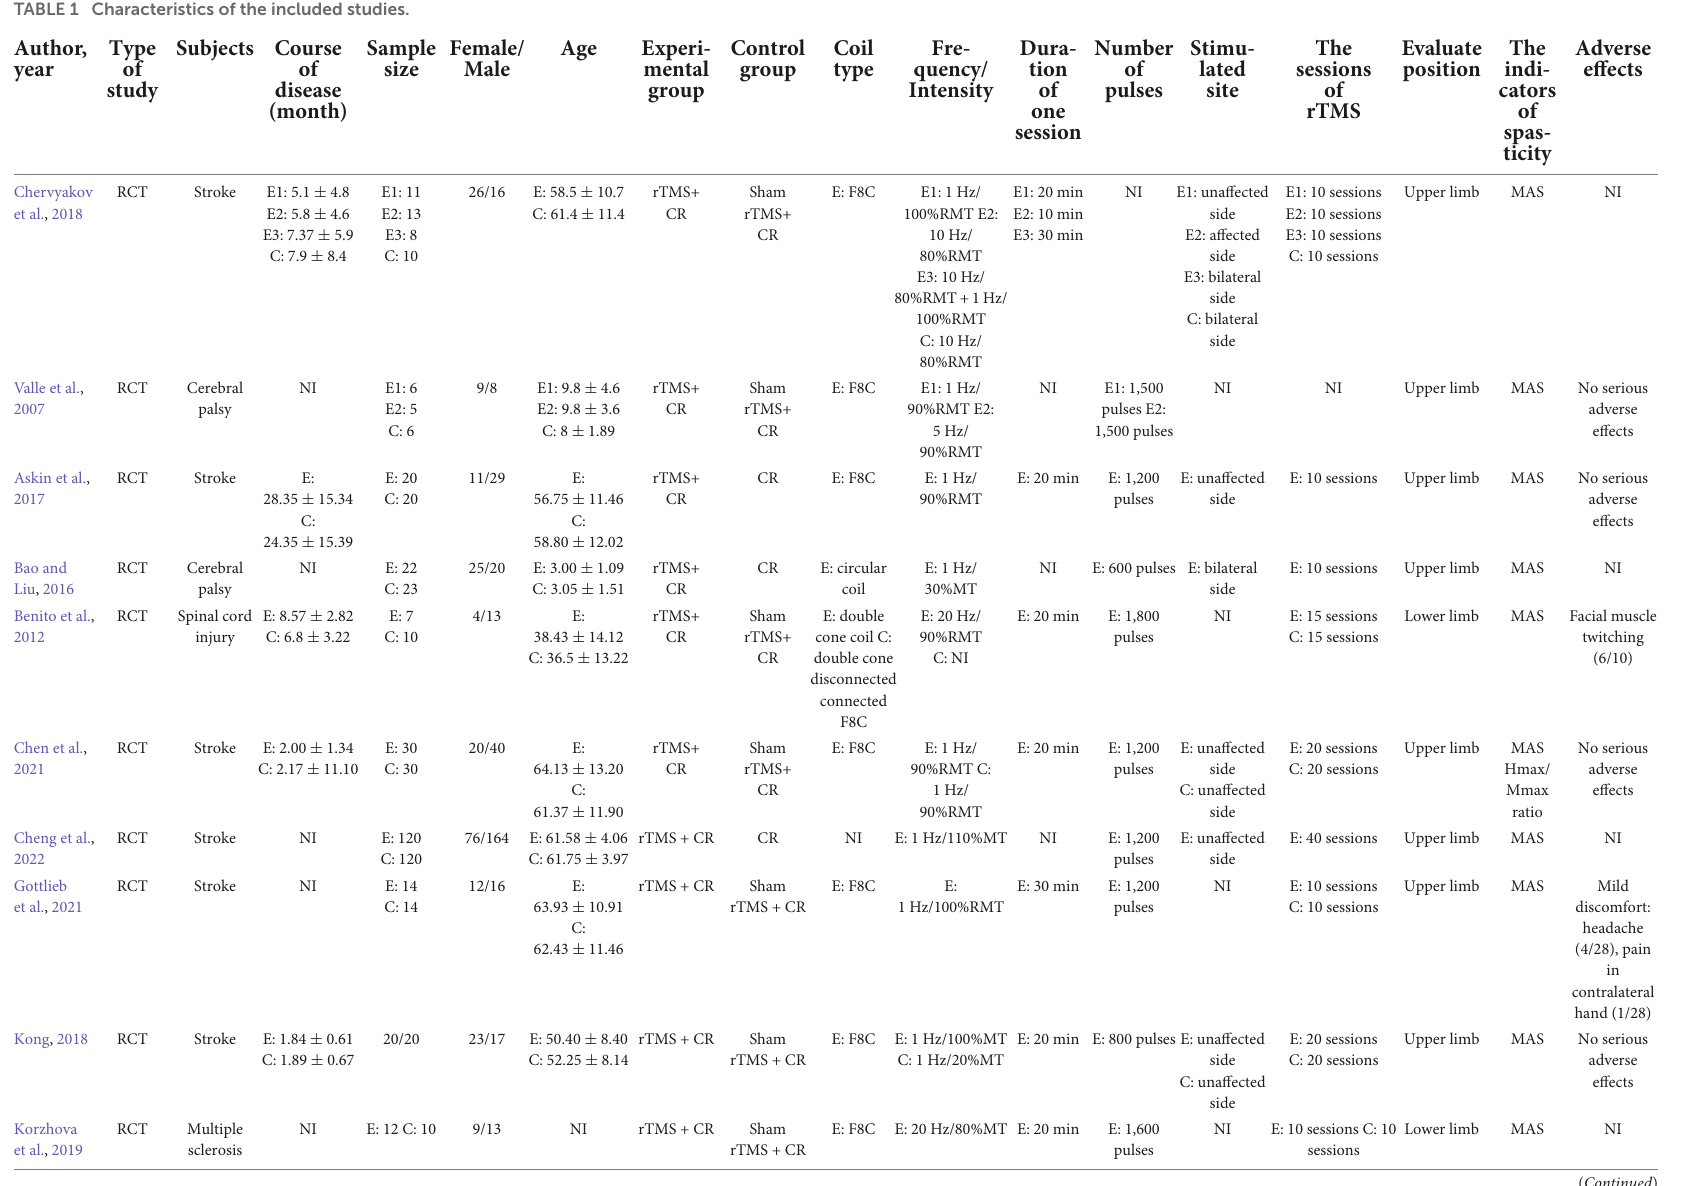
TABLE 1 Characteristics of the included